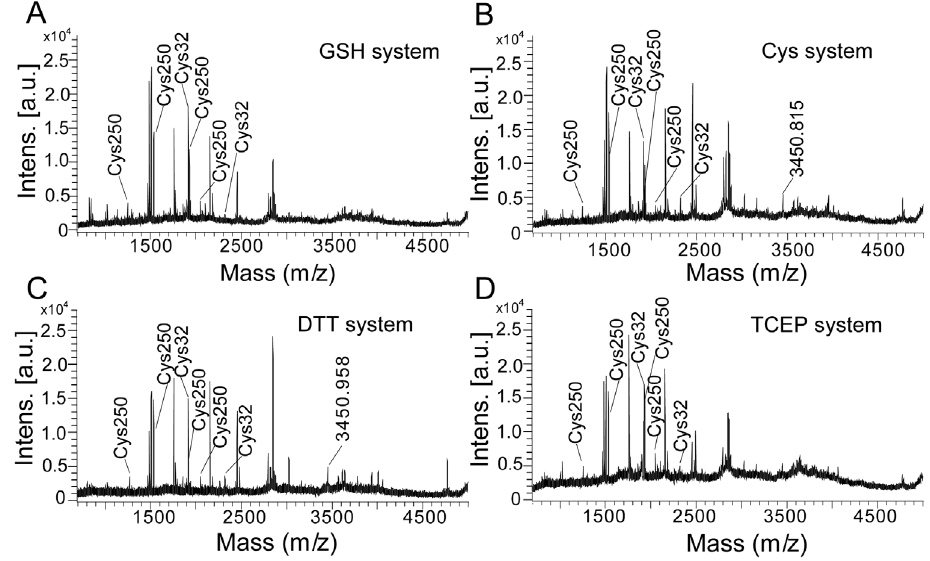
Figure 4. The effects of (A) GSH, (B) Cys, (C) DTT, and (D) TCEP on the Cys250-Cys32 disulfide bond. Before analysis, hAS3MT was respectively reduced by GSH (7 mM), Cys (10 mM), DTT (1.5 mM) or TCEP (0.7 mM) for 60 min at 37 u C.